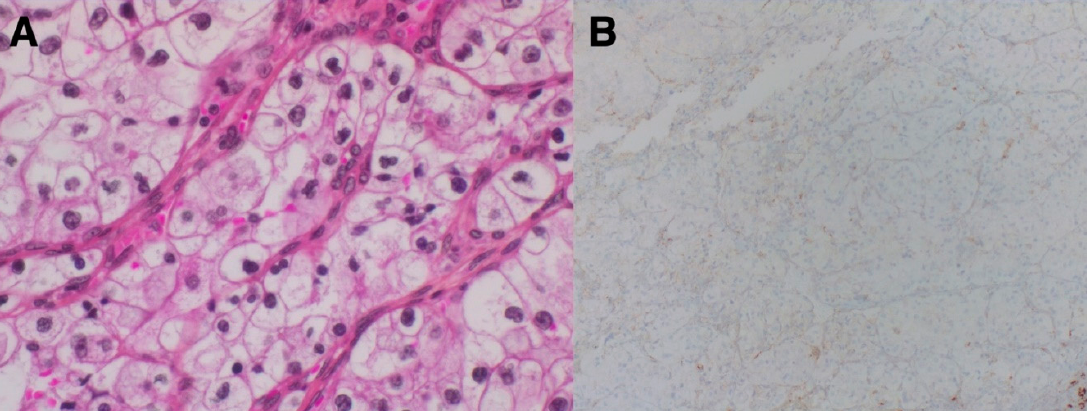
Figure 2. ( A ) Hematoxylin/eosin and phloxin staining for ccRCC without sarcomatoid features (400× magnification). ( B ) PD-L1 (E1L3N XP Rabbit mAB) cytoplasmatic staining of tumor cells, showing